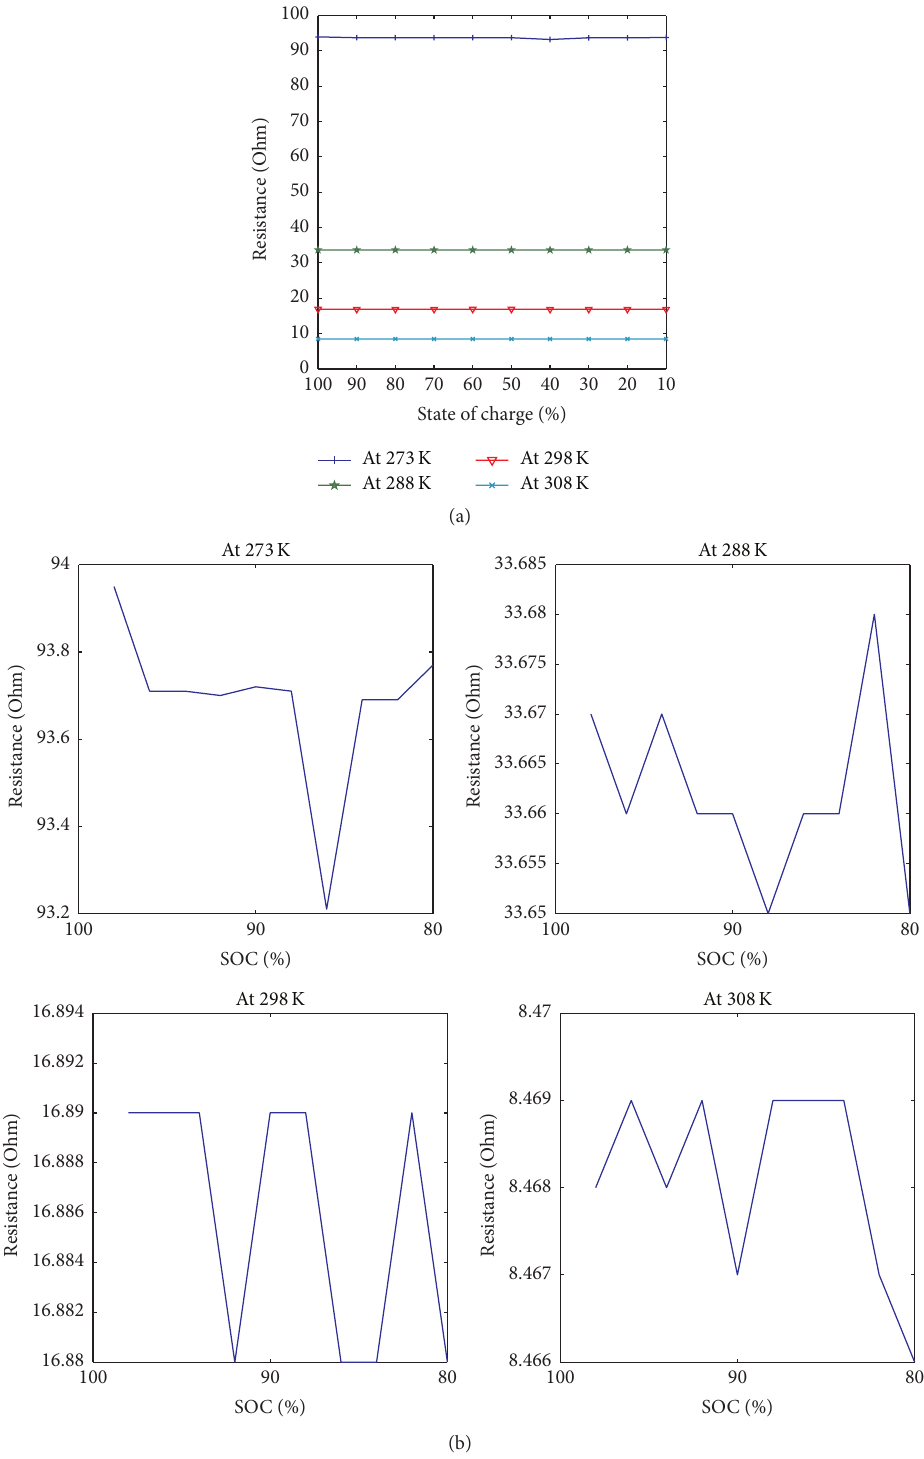
Figure 8: Resistance variation with varying SOC; (a) all temperatures in same plot and (b) plots for individual